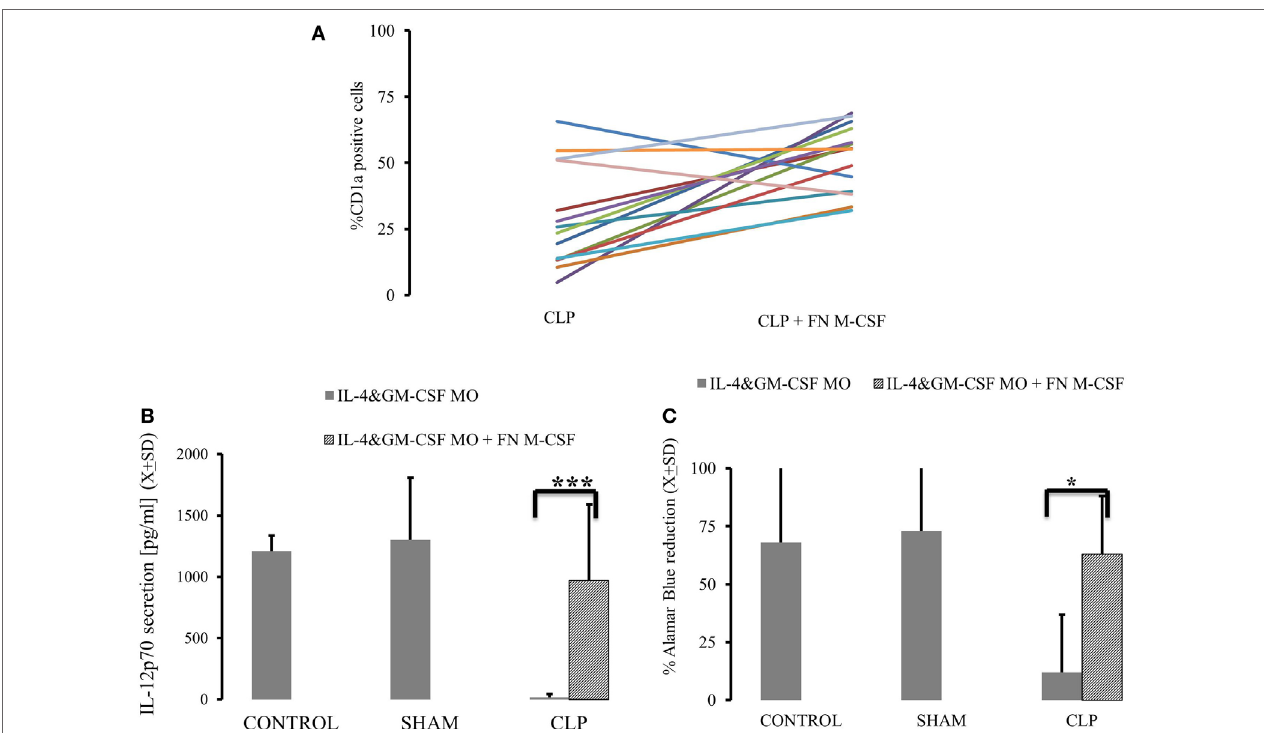
FigUre 4 | neutralizing macrophage-colony stimulation factor (M-csF) results in restoration of monocytes’ (MO) ability to become dendritic cell (Dc) in animals surviving cecal ligation and puncture (clP) . MO obtained from animals control animals (CONTR; n = 8), sham-operated (SHAM n = 6), and surviving CLP (CLP; n = 14) were incubated with IL-4&GM-CSF alone or with the presence of the antibody neutralizing M-CSF (FN M-CSF; 5 mg/ml). We presented expression of CD1a on the IL-4&GM-CSF alone and IL-4&GM-CSF + FN-M-CSF-enriched cultures from each single experiment for parallel comparisons (a) . We also measured recovery of the production of IL-12p70 (B) after lipopolysaccharide challenge in IL-4&GM-CSF alone and after adding FN M-CSF. Concomitantly, we measured ability of differentiated MO to stimulate T cells in mixed lymphocyte reaction showed as a reduction of Alamar Blue (c) . Solid gray bar represent experiment done with IL-4&GM-CSF alone. Oblique zebra bars represent experiments where FN-MC-CSF was supplemented. Bars represent average of results ( X ) with SD. Data were analyzed by t -test for parallel group comparisons (* p < 0.05, ** p < 0.01, *** p <